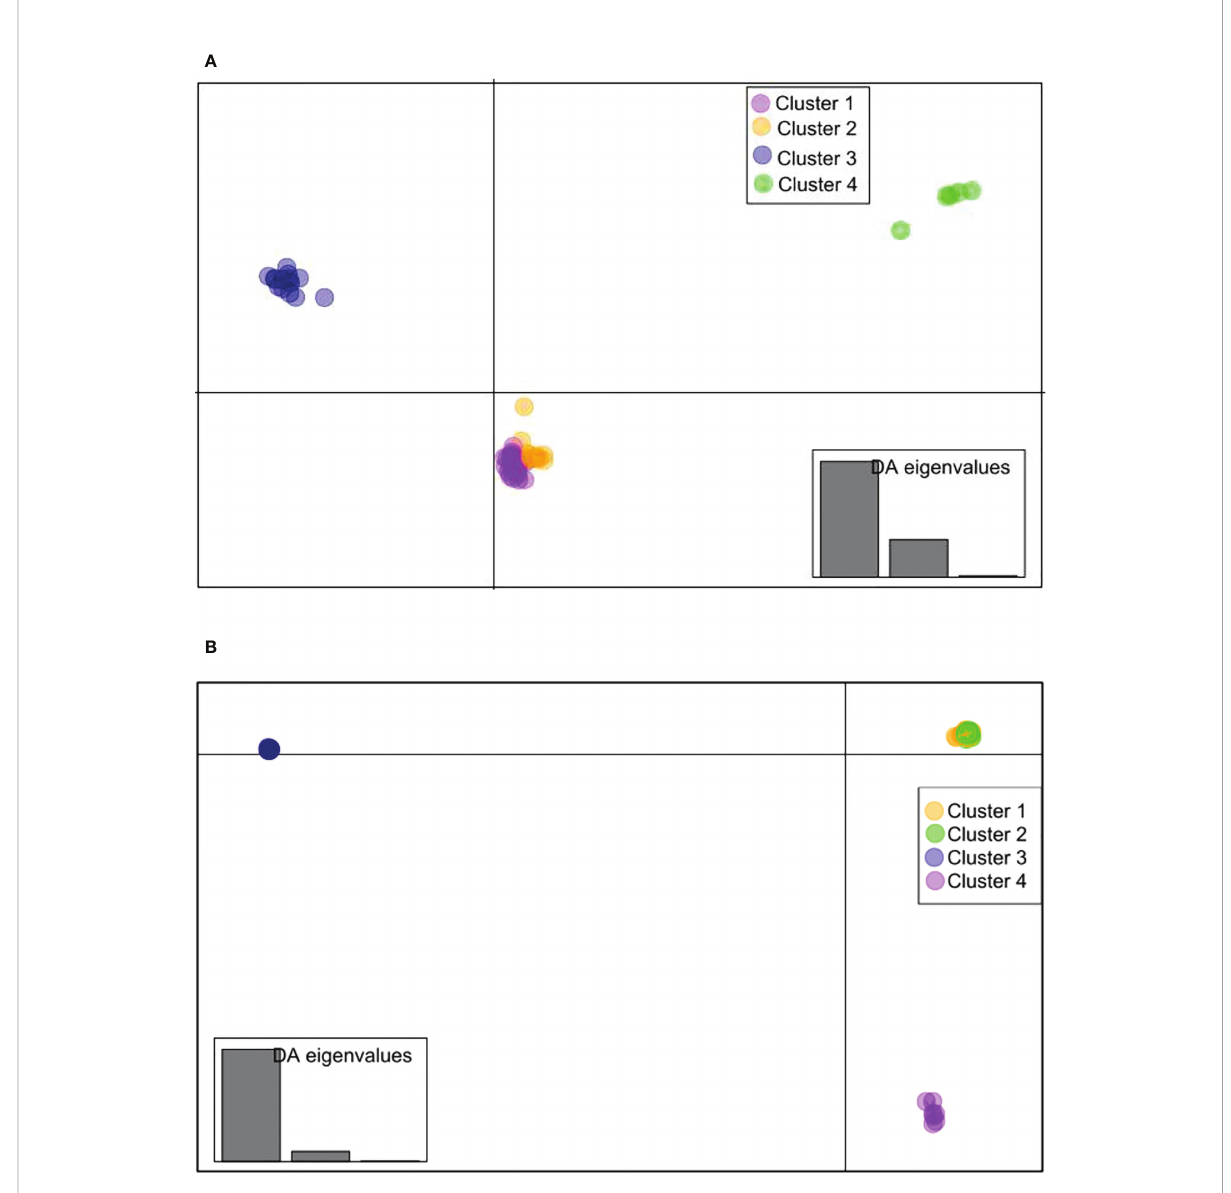
FIGURE 2 Discriminant analysis of principal components (DAPC) scatterplot drawn using SNPs in the R package adegenet (K =4). (A) Bipolaris oryzae , (B) Exserohilum rostratum . Each color represents a cluster obtained by DAPC analysis of isolates from different localities in Burkina Faso. For Bipolaris oryzae , Cluster 1 is composed of 27 isolates (Bagre = 4, Bama = 3, Banfora = 5, Banzon = 8 and Sourou =7), Cluster 2 is composed of 13 isolates (Bagre = 4, Bama = 3, Banfora = 1, Banzon = 2 and Sourou =3), Cluster 3 is composed of 16 isolates (Bagre = 1, Bama = 4 and Sourou =11), Cluster 4 is composed of 5 isolates (Banfora = 5). For Exserohilum rostratum , Cluster 1 is composed of 58 isolates (Bagre = 38, Bama = 4, Banfora = 4, Banzon = 2 and Sourou =10), Cluster 2 is composed of 60 isolates (Bagre = 23, Bama = 4, Banfora = 7, Banzon = 2 and Sourou =24), Cluster 3 is composed of 26 isolates (Bagre = 5, Bama = 5, Banfora = 2 and Sourou =14) and Cluster 4 is composed of 7 isolates (Bagre = 3, Banzon = 1 and Sourou =